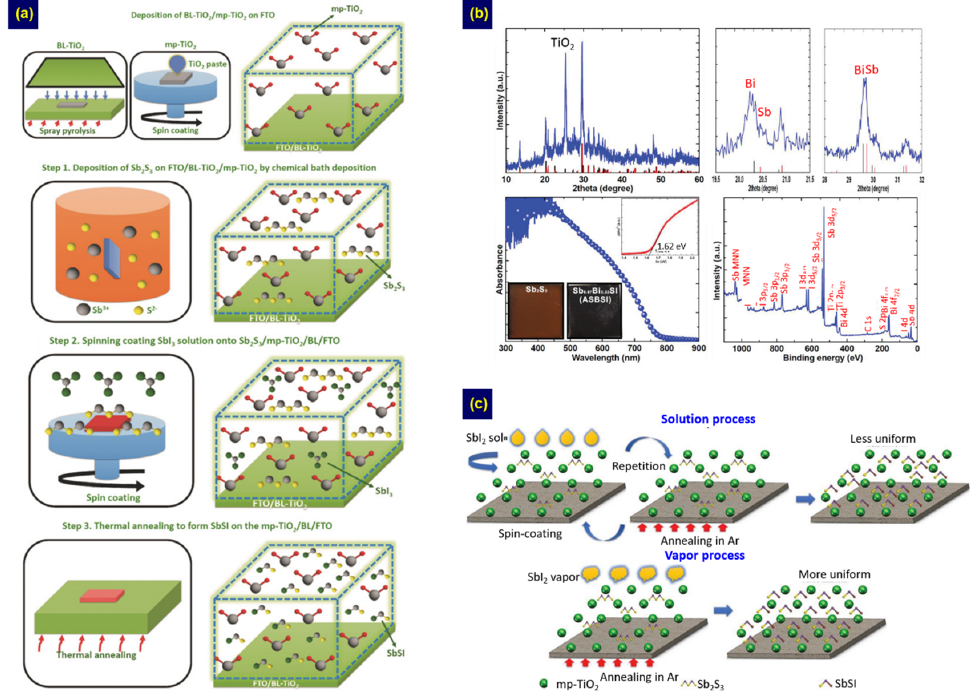
Figure 4. ( a ) Schematic illustration of the two-step method for SbSI fabrication. Adapted from [38], with permission from John Wiley and Sons, 2017; ( b ) Structure, absorption, and X-ray photoelectron spectroscopy properties of the Sb 0.67 Bi 0.33 SI. Adapted from [23], with permission from John Wiley and Sons, 2019; ( c ) Schematic illustration of the two processes utilized in step 2 of the SbSI fabrication. Adapted from [65], with permission from John Wiley and Sons, 2019.